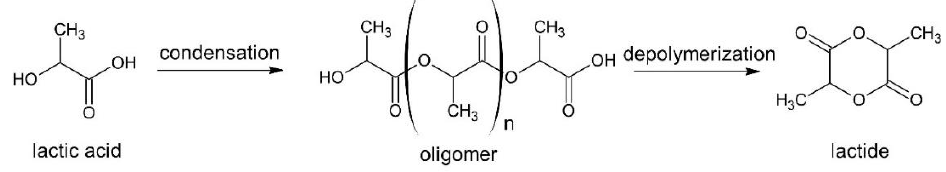
Figure 2. Lactide dimer synthesis (reprinted with permission [12], Copyright 1998 Elsevier).